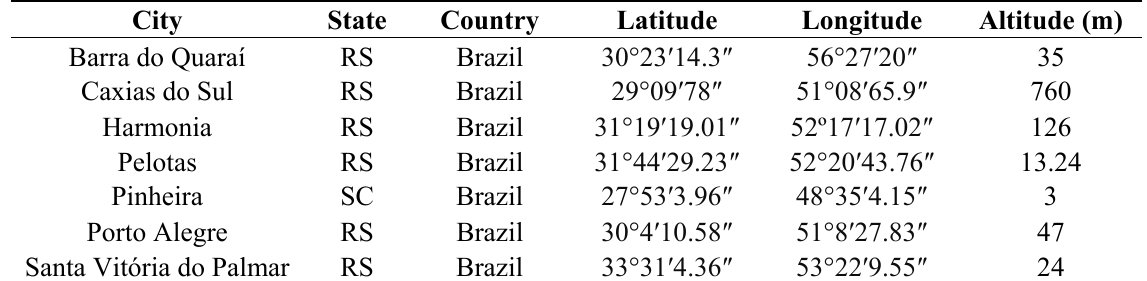
Table 1. Localization of the geographical regions of origin of the different Lippia alba